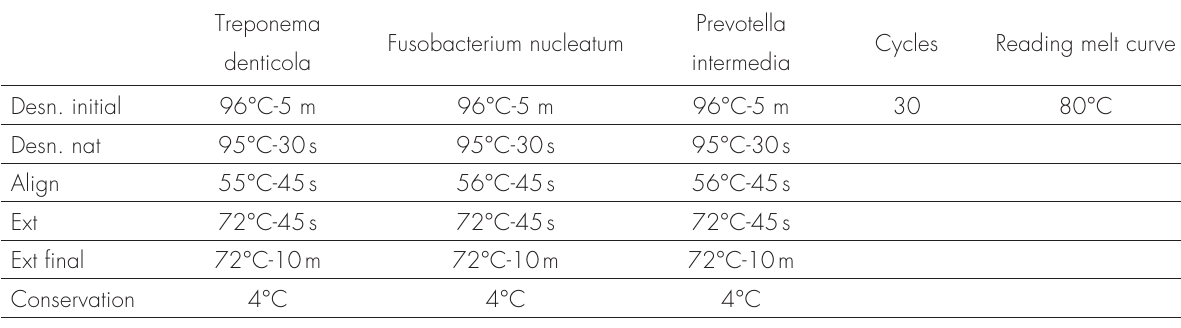
Table II. qPCR conditions to measure bacterial load.